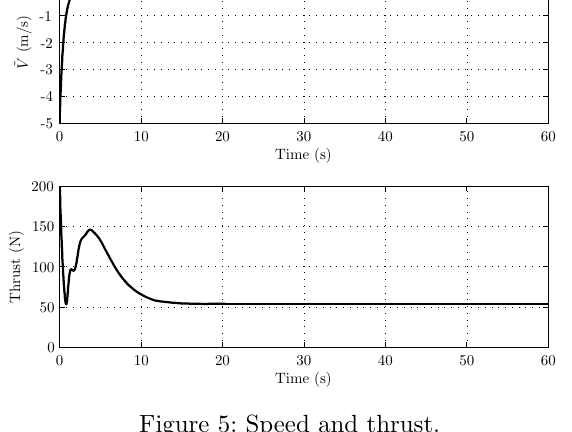
Figure 5: Speed and thrust.